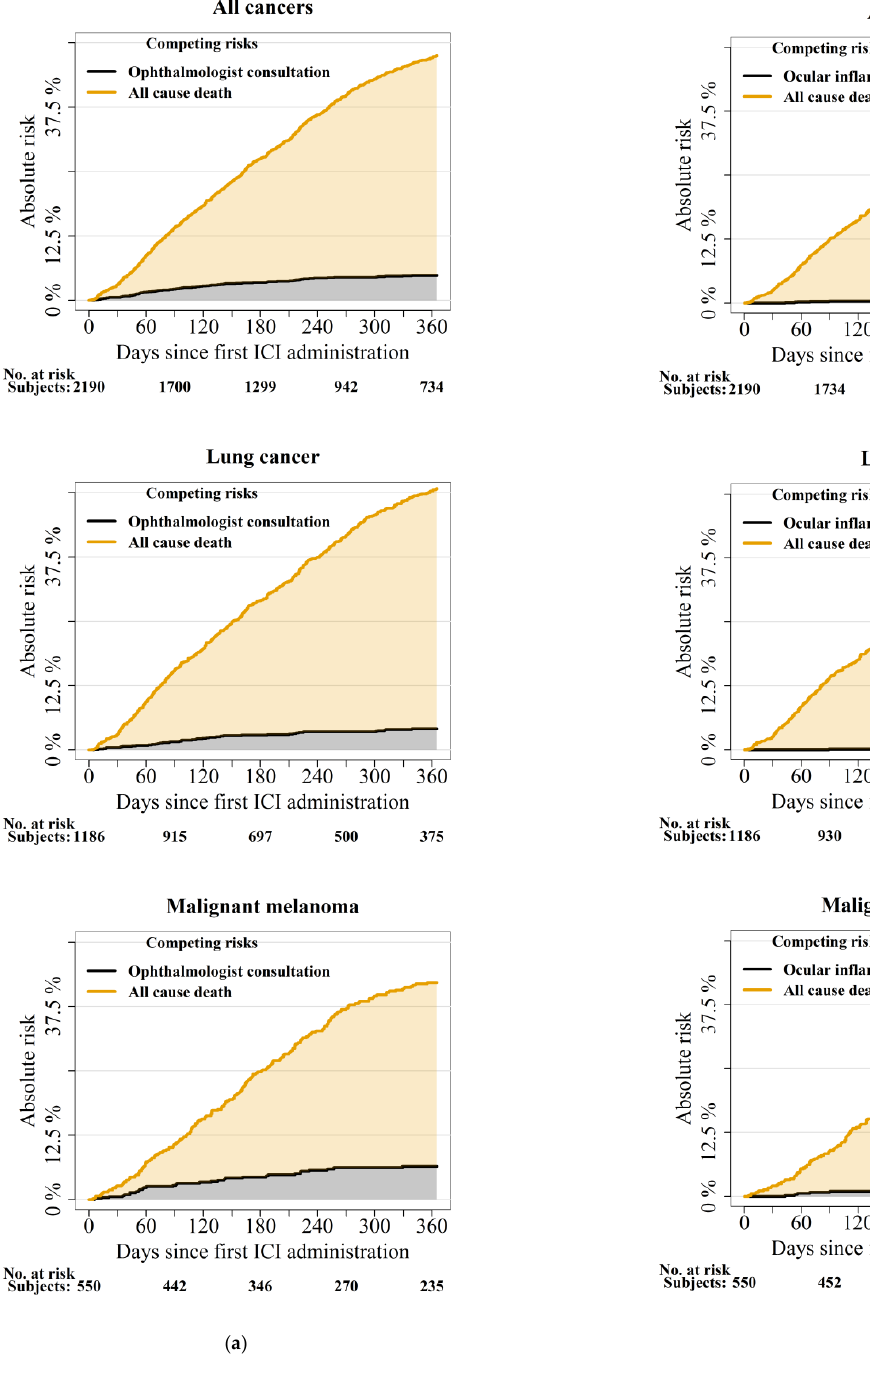
Figure 2. ( a ) Absolute one-year risk of first-time ophthalmologist consultation in patients treated with ICI. ( b) Absolute one-year risk of first-time ocular inflammation in patients treated with ICI.